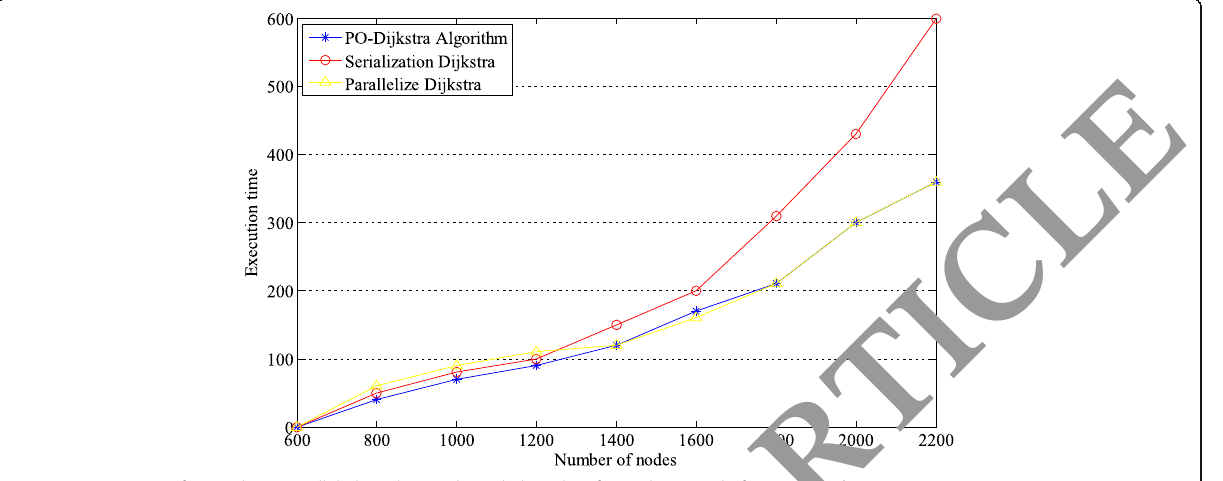
Fig. 5 Comparison of PO-Dijkstra parallel algorithm and serial algorithm for multi-core platform